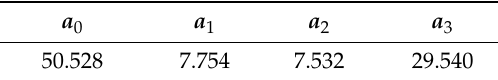
Table 6. Coe ffi cients of BOA-LIN